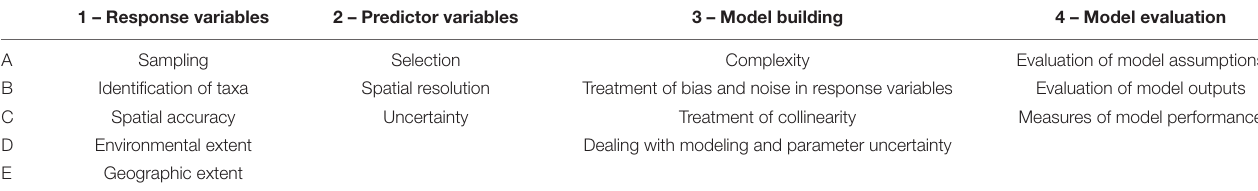
TABLE 2 | Predictive model assessment criteria (1–4) and issues (A–E) proposed by Araujo et al.